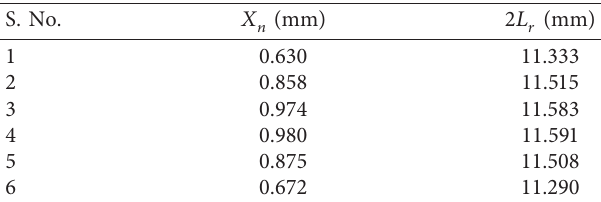
Table 2: Slot parameters for nose-cone conformal antenna with interelement spacing of λ g